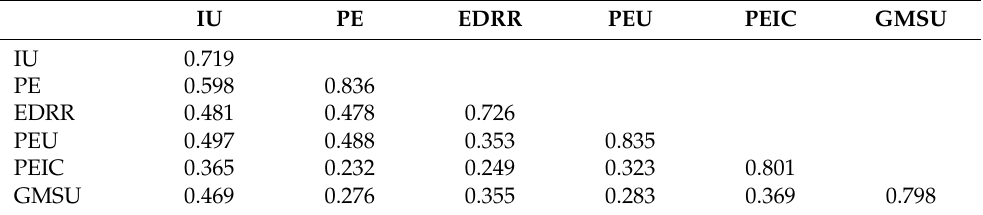
Table 6. Discriminant validity